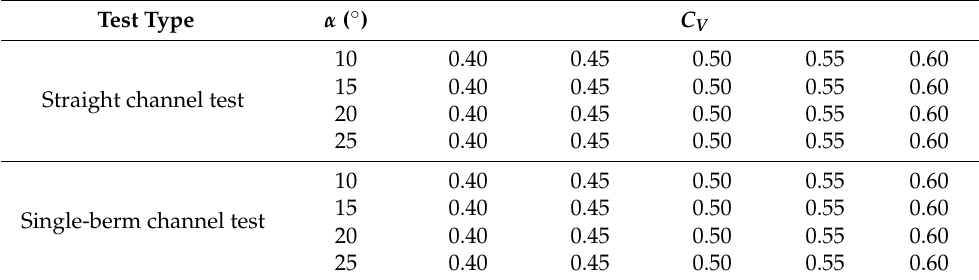
Table 1. Experimental conditions for laboratory tests.